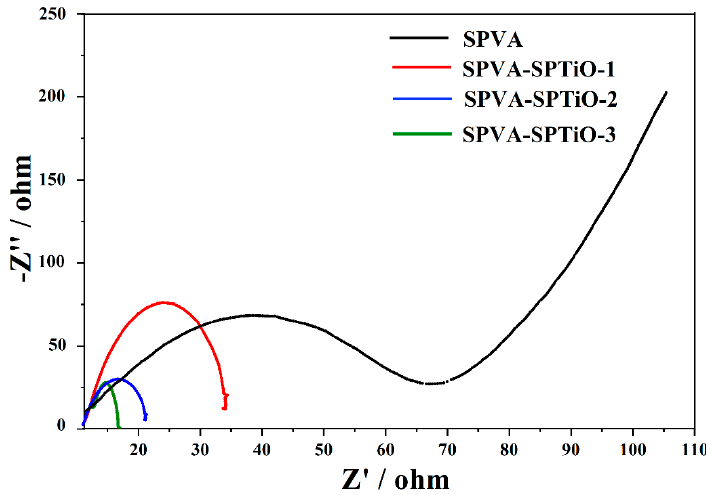
Figure 10. Impedance measurements of the doped membranes and of the undoped membrane.